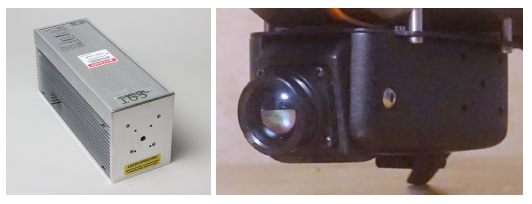
Figure 3. Iradion® Infinity CO 2 laser and MH SM567 thermal